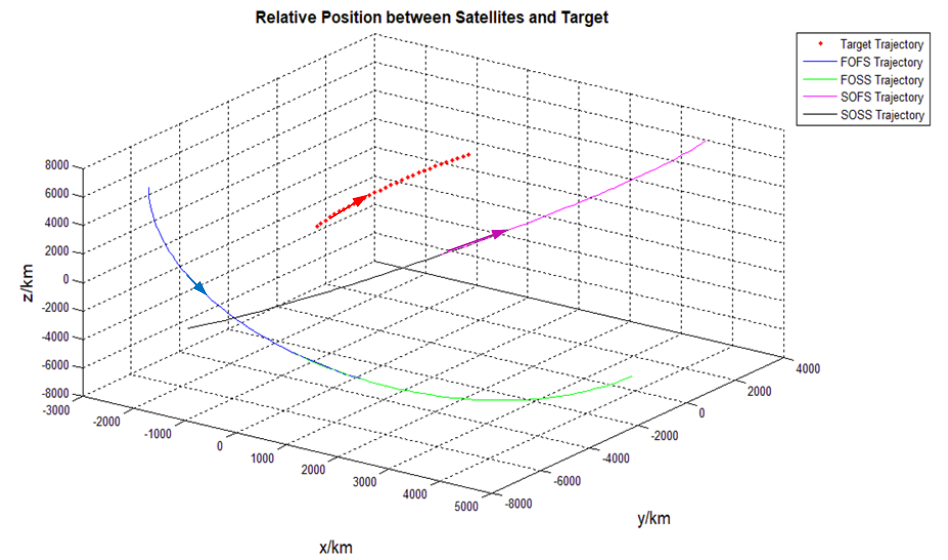
Figure 17. Selection of orbit planes and satellites for target4.